Question: Identify the chart type used in this figure.
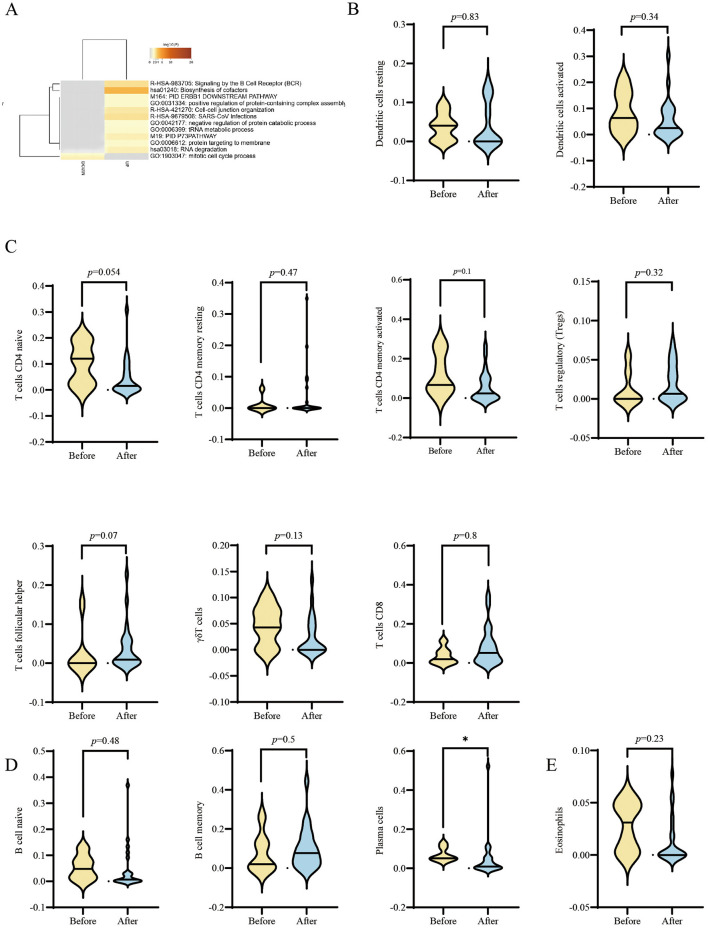
Answer: heatmap